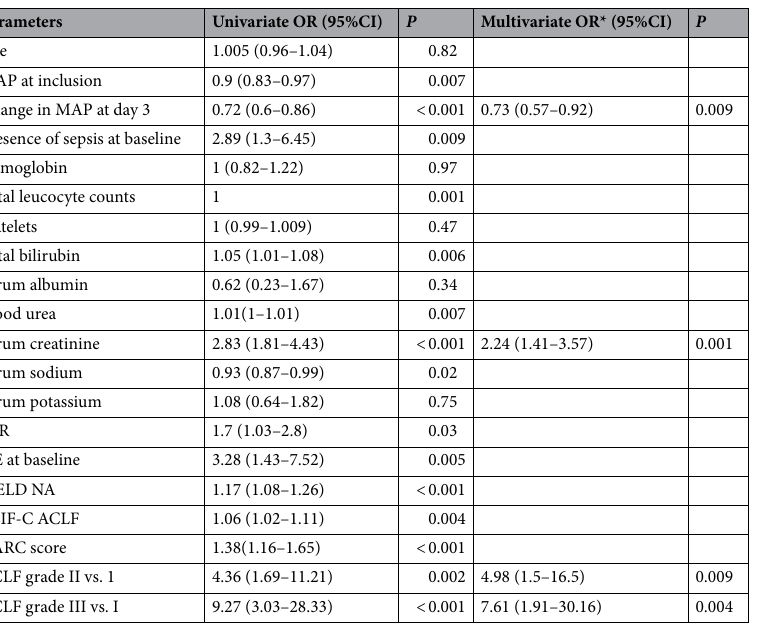
Table 4. Predictors of terlipressin non-response on univariate and multivariate stepwise logistic regression analysis. OR odds ratio, EASL European association for the study of the liver, ACLF acute-on-chronic liver failure, MAP mean arterial pressure, INR international normalized ratio, HE hepatic encephalopathy, MELD NA model for end-stage liver disease sodium, CLIF-C ACLF chronic liver failure consortium acute-on- chronic liver failure score, AARC APASL ACLF research consortium. *Change in MAP at day 3, ACLF grade, Creatinine, Sepsis, TLC, HE, MAP day 1, blood urea, sodium, INR, Total bilirubin, AARC score, CLIF-C score, MELD NA